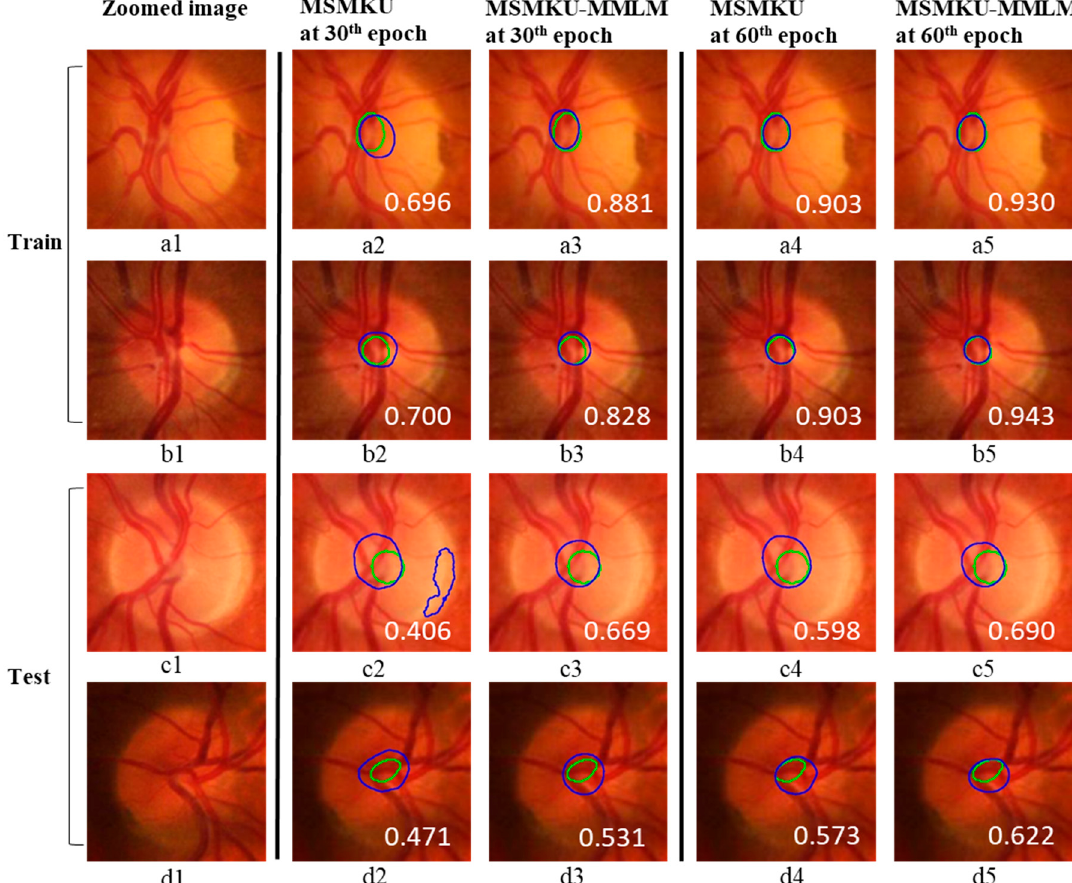
Figure 9. Examples with the smallest F -scores of optic cup segmentation by MSMKU–MMLM and MSMKU. The images on the first two rows are results on the training set and the images on the second two rows are the results on the test set. From the first to fifth column, the examples are zoomed image, segmentation results by MSMKU at 30th epoch, MSMKU–MMLM at 30th epoch, MSMKU at 60th epoch, and MSMKU–MMLM at 60th epoch, respectively. The green contours refer to the ground truth while the blue ones indicate the results of the different segmentation methods. The value of F-score of OC is shown in each image.